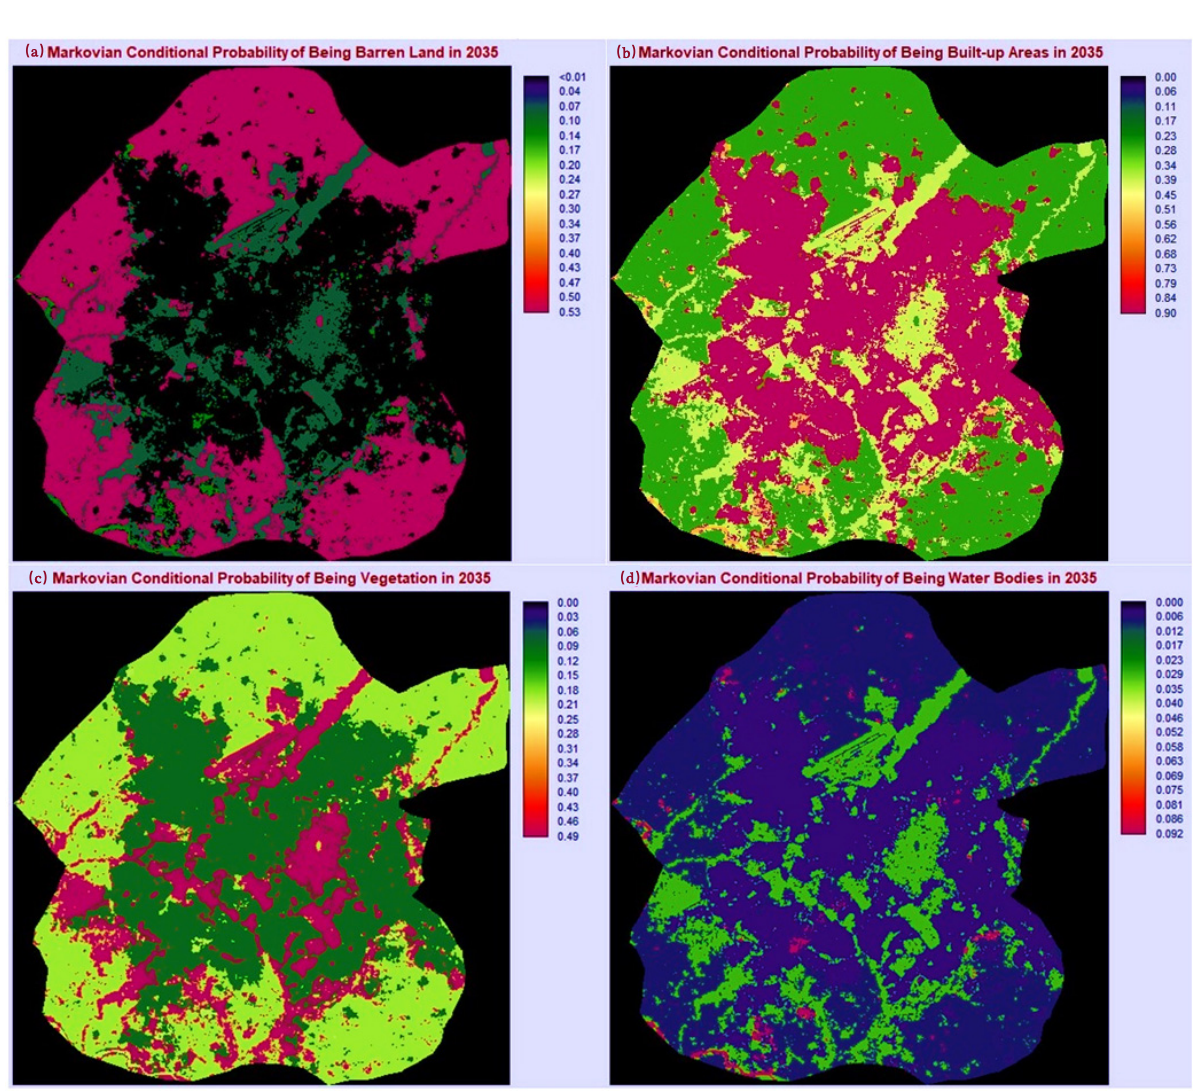
Figure 6. Markovian conditional probabilities for the predicted, ( a ) Barren Land, ( b ) Built-up Areas, ( c ) Vegetation, and ( d ) Waterbodies in